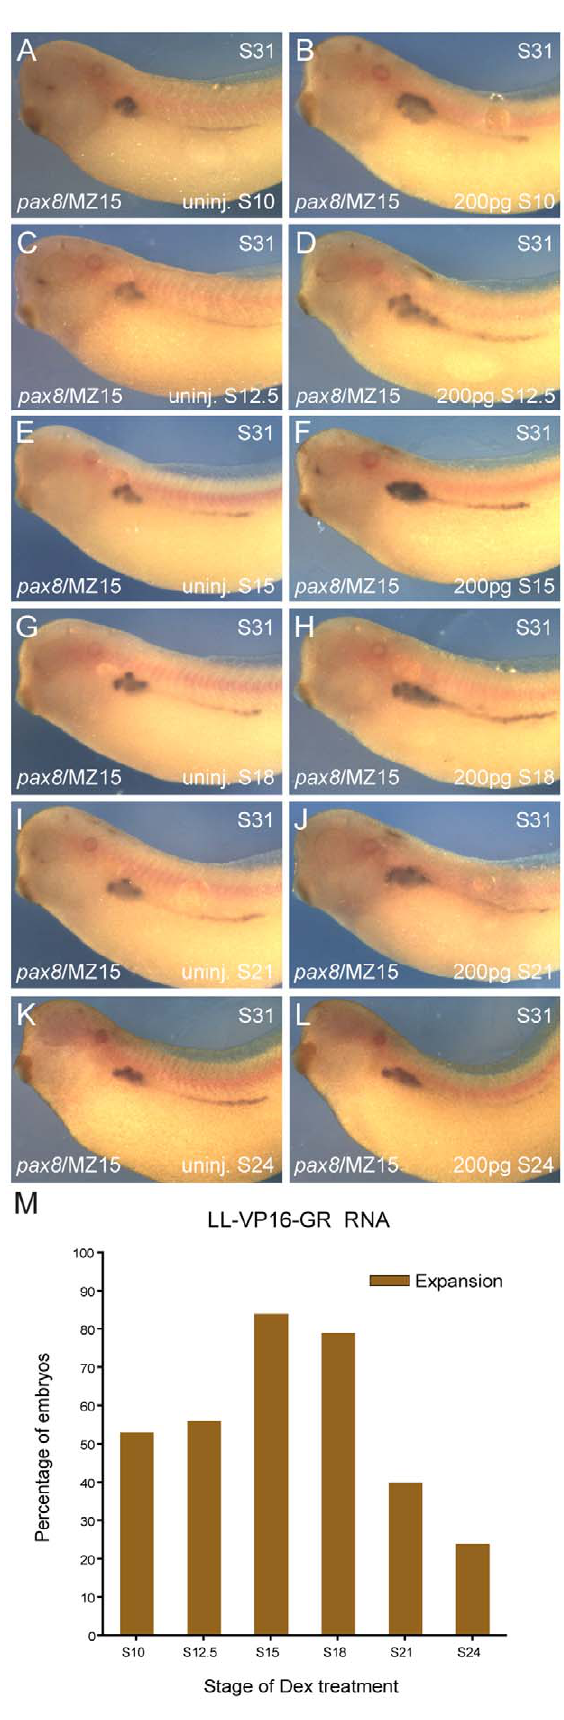
Figure 2. Inducible activation of Lhx1, defines a temporal window of kidney field expansion. Embryos were injected (1xV2) with 200 pg of LL-VP16-GR mRNA at the 8-cell stage. ( A–L ) In situ hybridization for pax8 of embryos at stage 31, followed by MZ15 whole- mount immunostaining. ( A, C, E, G, I, K ) Uninjected embryos. ( B, D, F, H, J, L ) Injected embryos. Activation of LL-VP16-GR was controlled